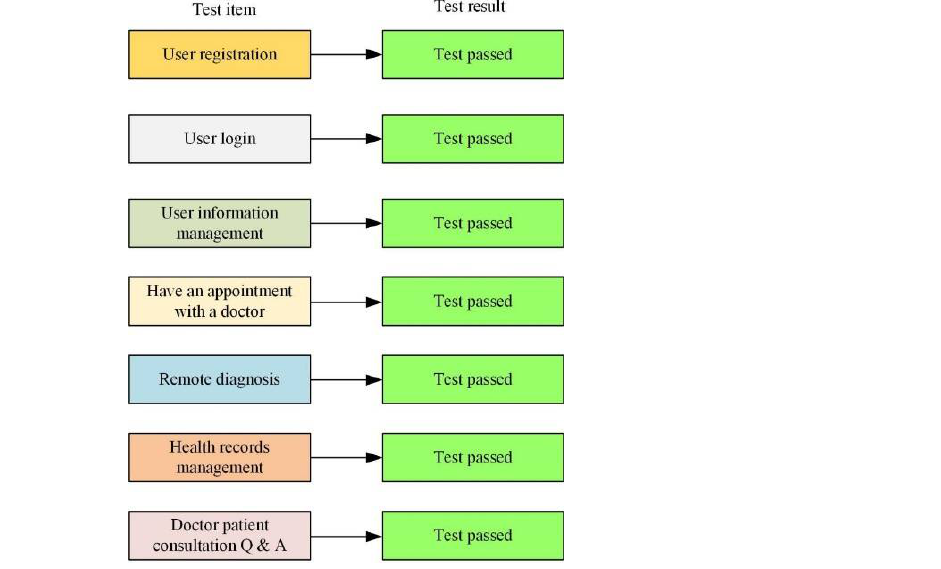
Figure 6. Testing of functions and services (drawn according to the test results after research and design combined with data).